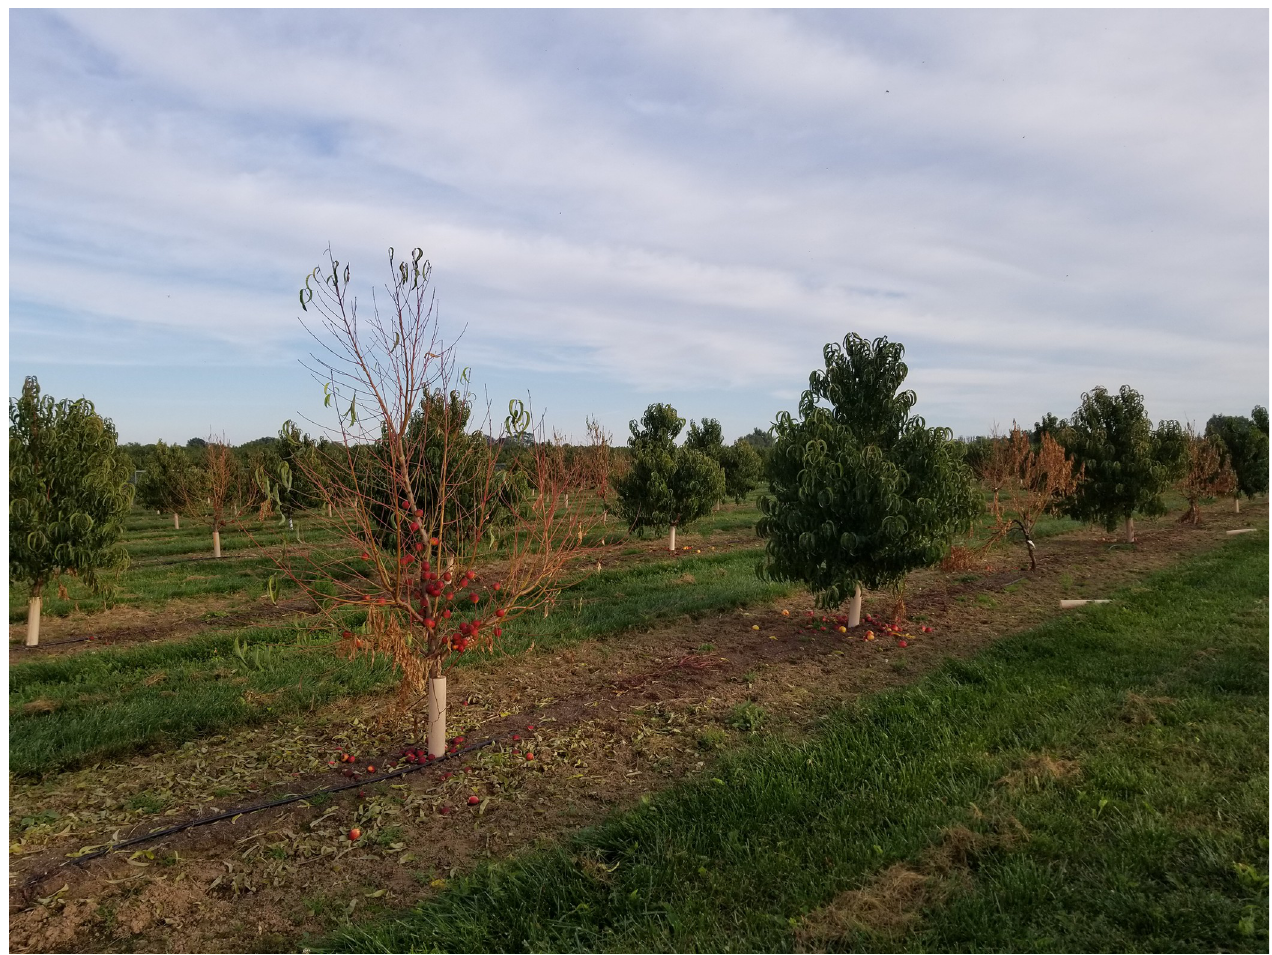
Fig 1. Nectarine trees showing fruit tree decline syndrome (FTDS) in southern Ontario,